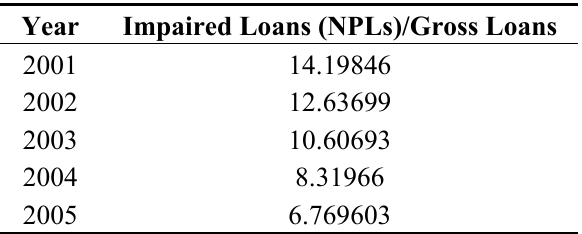
Table A1. Mean value of financial fragility in sample countries during period from 2001 to